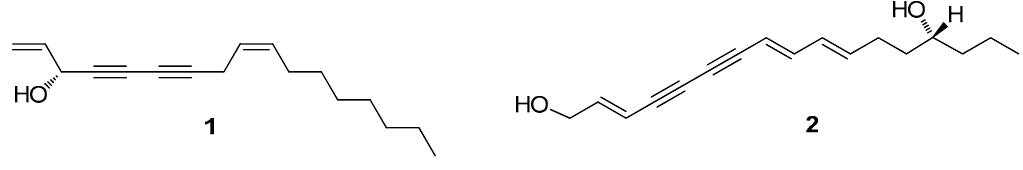
Figure 1. The chemical structures of two archetypal C 17 polyacetylenes, falcarinol ( 1 ) and oenanthotoxin ( 2 ).